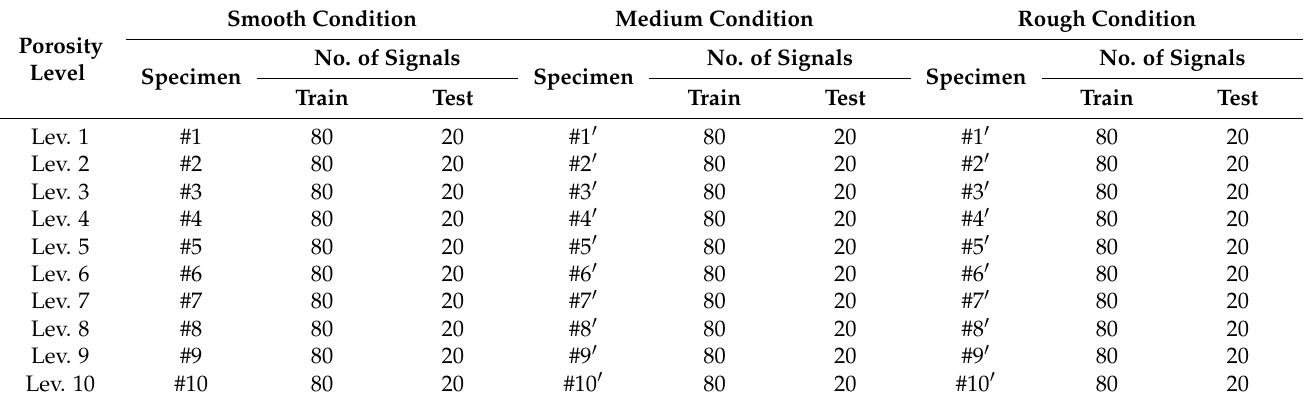
Table 5. Training and testing datasets according to roughness condition and porosity